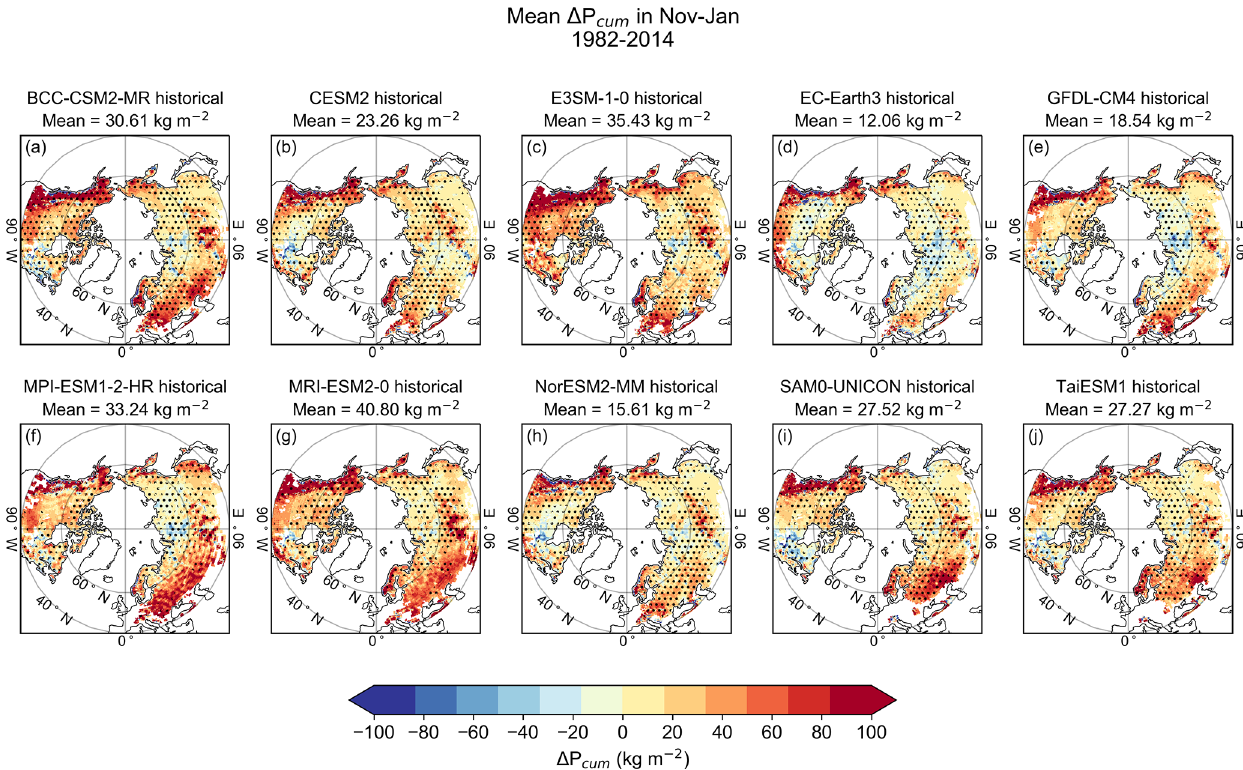
Figure 4. The mean model bias in P cum ( (cid:49)P cum , model minus observation) in snow-covered areas from November to January 1982–2014. The dots indicate areas where the models either overestimate both SWE and P or underestimate both SWE and P